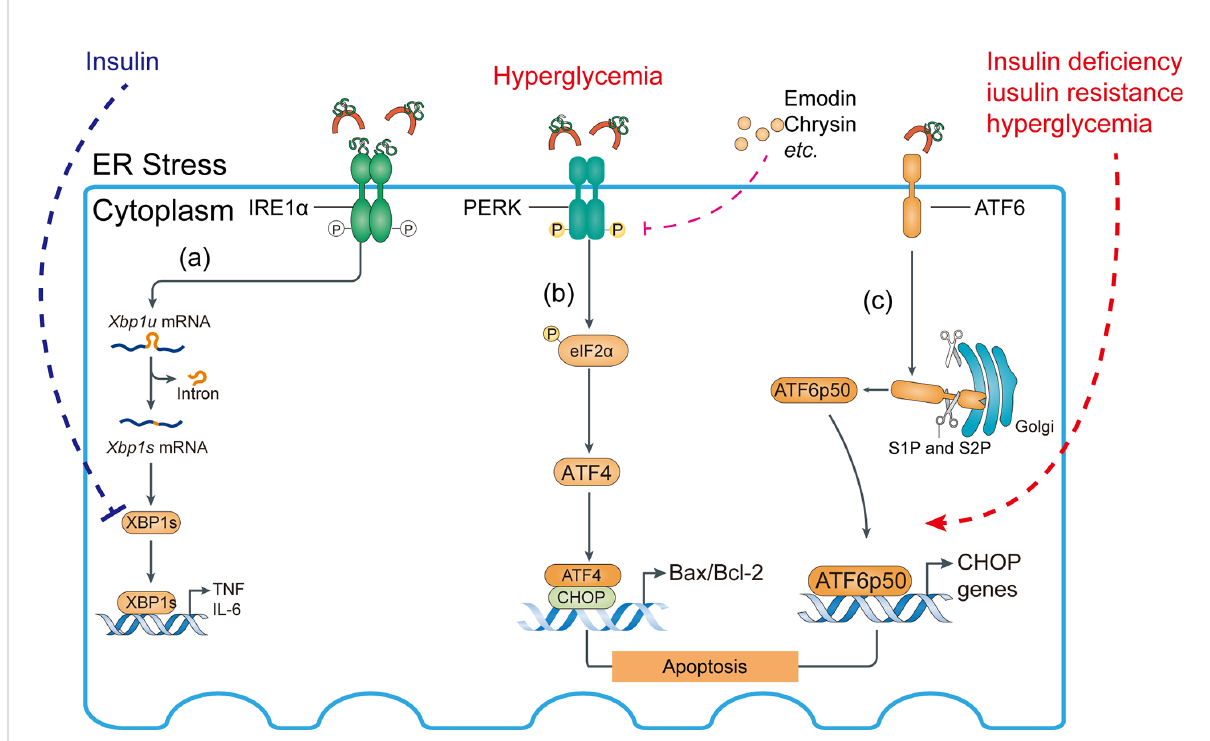
FIGURE 6 Activation of ATF6 pathway and abnormal IRE1 pathway may aggravate ER stress response. (A) Role of the IRE1 pathway in the ER stress response. Insulin signaling inhibits the interaction of XBP1s with the phosphatidylinositol 3-kinase (PI3K) regulatory subunits p-85 a and p-85 b , suppressing proin fl ammatory cytokine production. (B) Compounds such as emodin and chrysin inhibit PERK activation and decrease the Bax/ Bcl-2 ratio in hyperglycemia, preventing podocyte apoptosis. (C) Insulin de fi ciency, insulin resistance, and hyperglycemia aggravate site 1 protease (S1P)- and S2P-mediated cleavage of ATF6 a , allowing their fragments to translocate to the